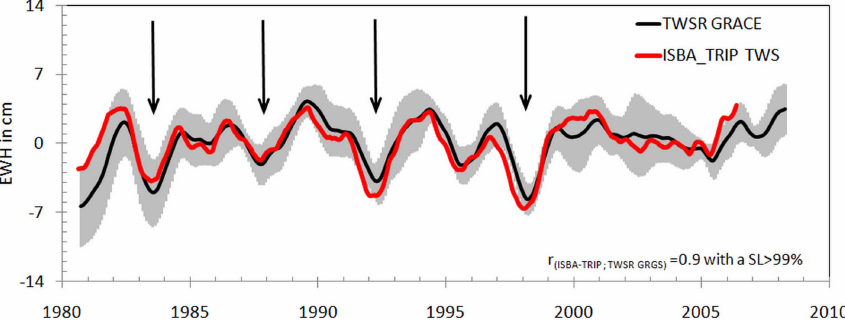
Fig. 7. Basin-averaged of the TWSR comparison with ISBA-TRIP. The basin-averaged of the TWSR is the black line and its error bars are in grey. The error in TWSR computed here is the sum of the error due to the least squares method and the error of the in situ records. This signal accounts for 60% of the total reconstructed signal variance. ISBA-TRIP is in red line. The El Ni˜no events are represented by arrows. We filtered out the high frequencies ( > 1yr − 1 ) using a simple 12-month running mean. r is the correlation coefficient (with a significance level higher than